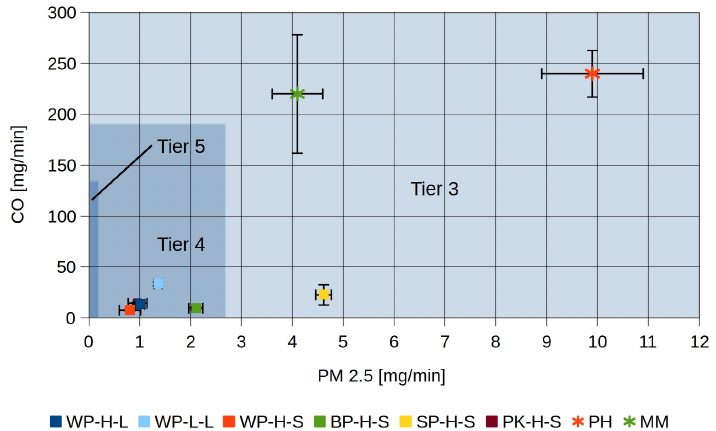
Figure 6. Indoor emissions of the Apeli stove in comparison with the Philips HD4012 [10] and Mimi Moto [10] stoves at high power output. Con fi dence intervals (90%), as speci fi ed in ISO 19867-1 [16], using pooled standard deviations are represented by the error bars; PK-H-S is behind WP-H-L.